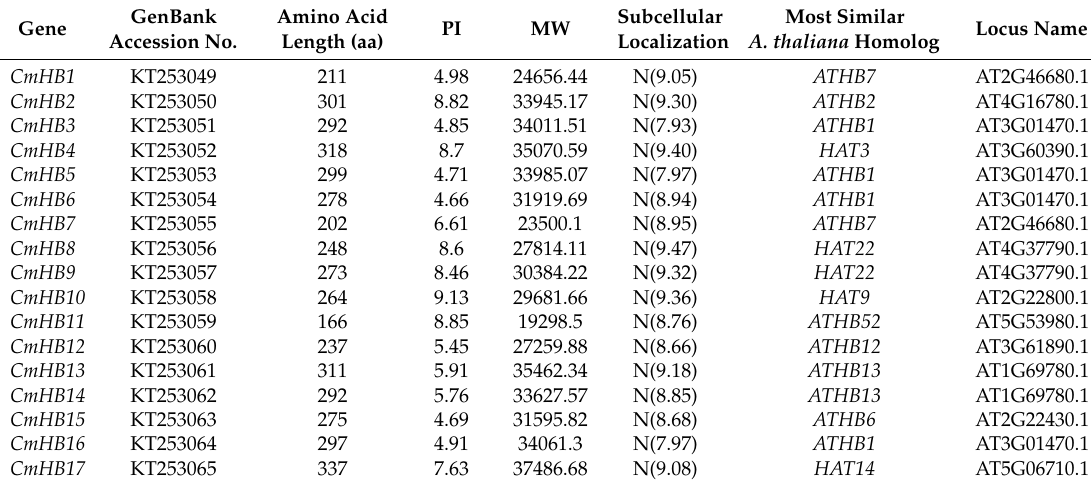
Table 1. Summary of CmHB sequences and the most similar A. thaliana